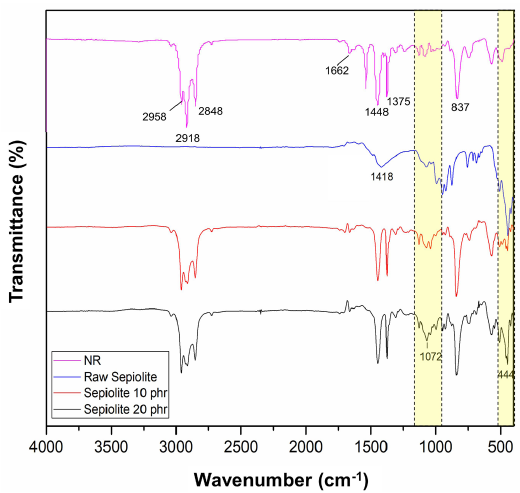
Figure 2. FTIR spectrum of raw sepiolite, NR and sepiloite filled NR composites.